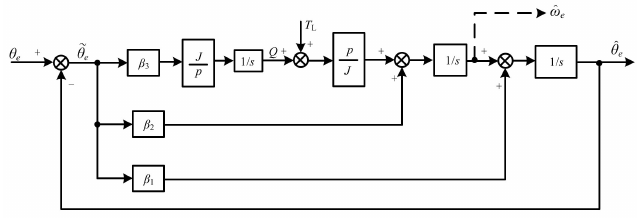
Figure 6. The third-order ESO structure